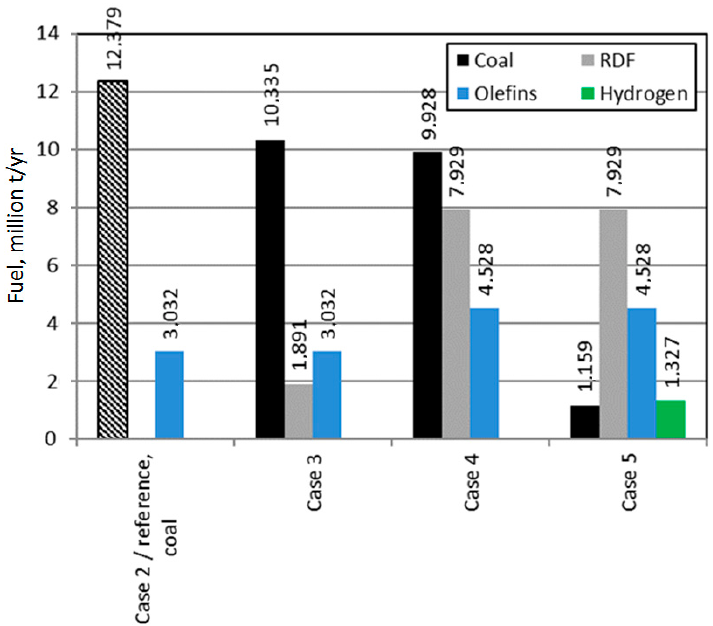
Figure 13. Consumption of hard coal and RDF and amount production of olefins.